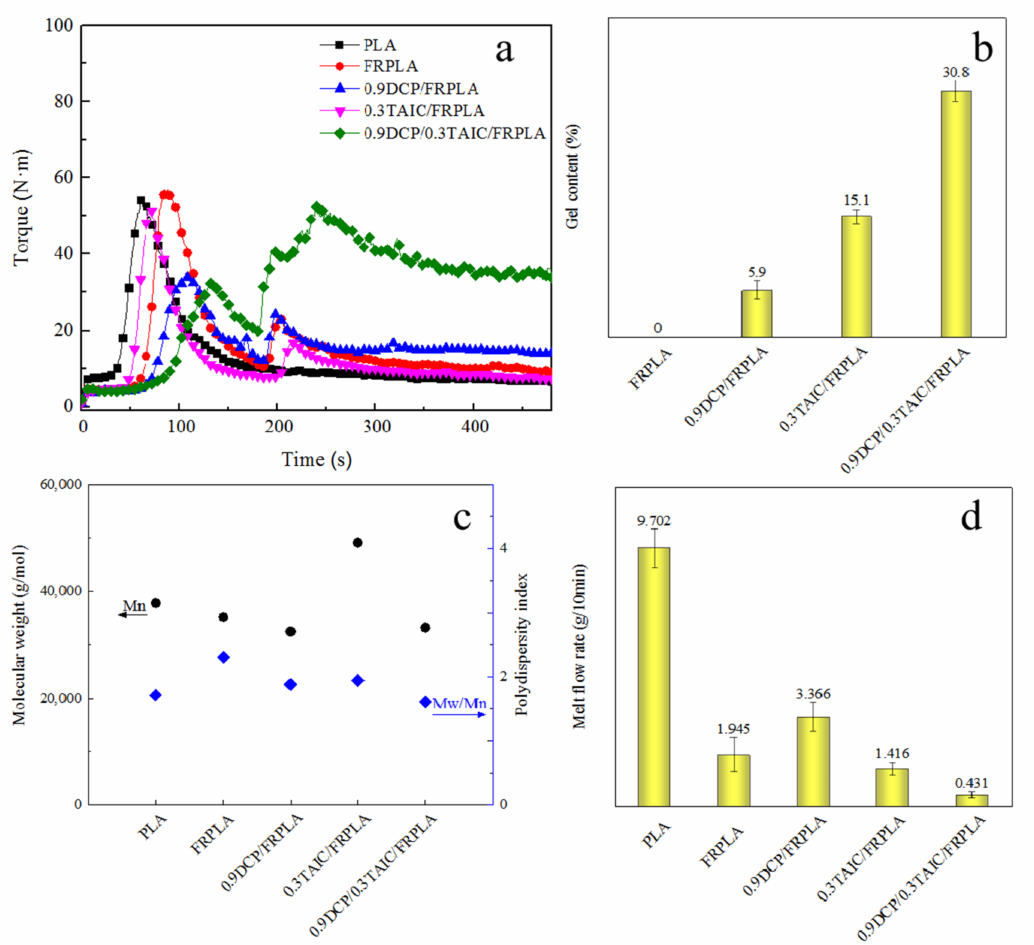
Figure 2. Characterization of crosslinked structures: ( a ) Torque curve; ( b ) gel content; ( c ) molecular weight; ( d )